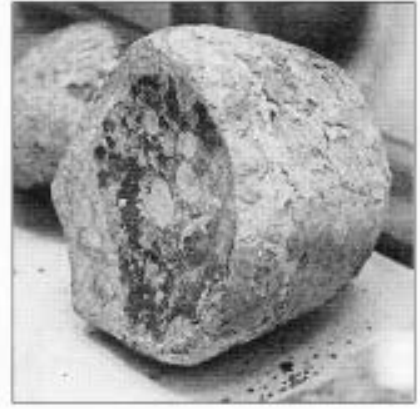
Figure 7 A glass ingot (approx. 10cm thick) excavated by M. Hamza in Qantir in 1928.